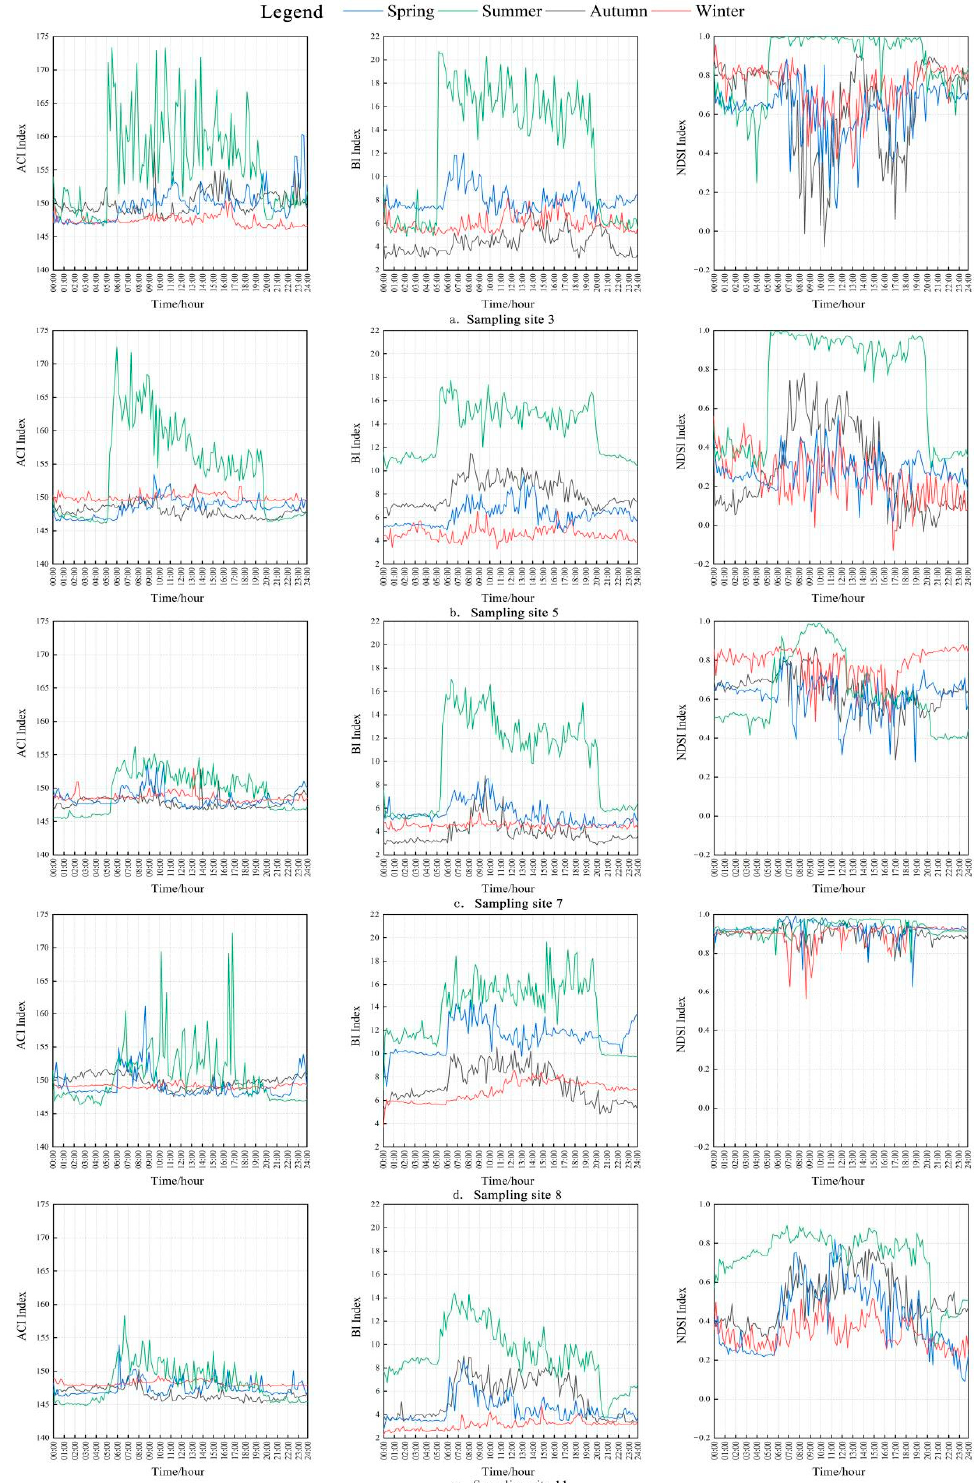
Figure 6. Diurnal dynamic characteristics of acoustic indices in different seasons at different sampling sites ( a – e ). The subfigures from column 1 to 3 are dynamics of ACI, Bi and NDSI in 5 sampling sites. Bird calls were active in summer, there were obvious diurnal patterns of acoustic indices dynamics in sampling sites.